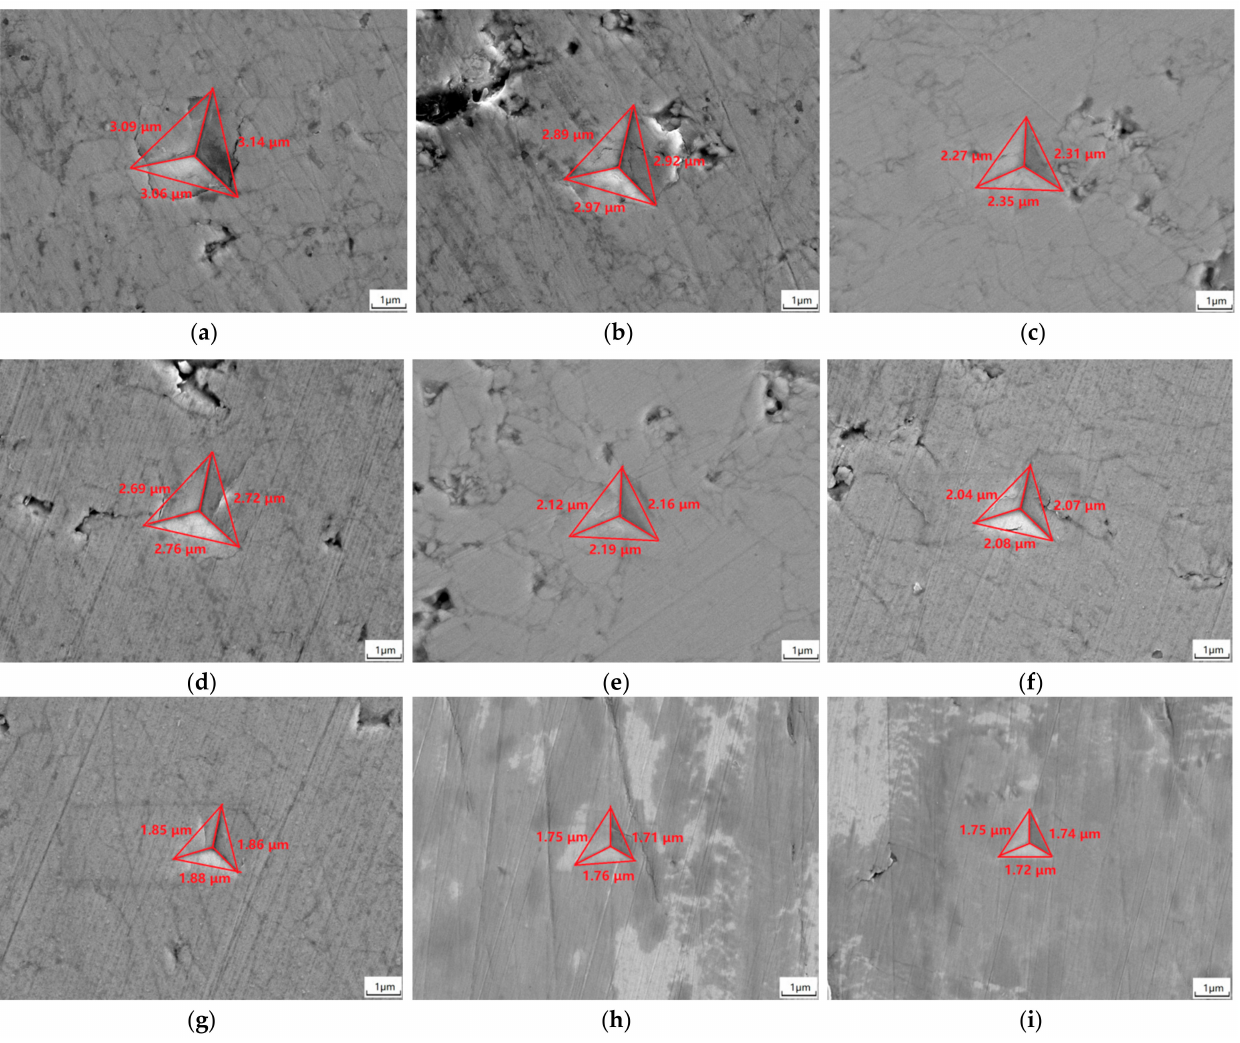
Figure 8. Indentations of the Gd 2 O 3 bulks sintered at 1400 ◦ C for 6 h ( a ), 12 h ( b ), and 24 h ( c ); indentations of the Gd 2 O 3 bulks sintered at 1500 ◦ C for 6 h ( d ), 12 h ( e ), and 24 h ( f ); indentations of the Gd 2 O 3 bulks sintered at 1600 ◦ C for 6 h ( g ), 12 h ( h ), and 24 h ( i